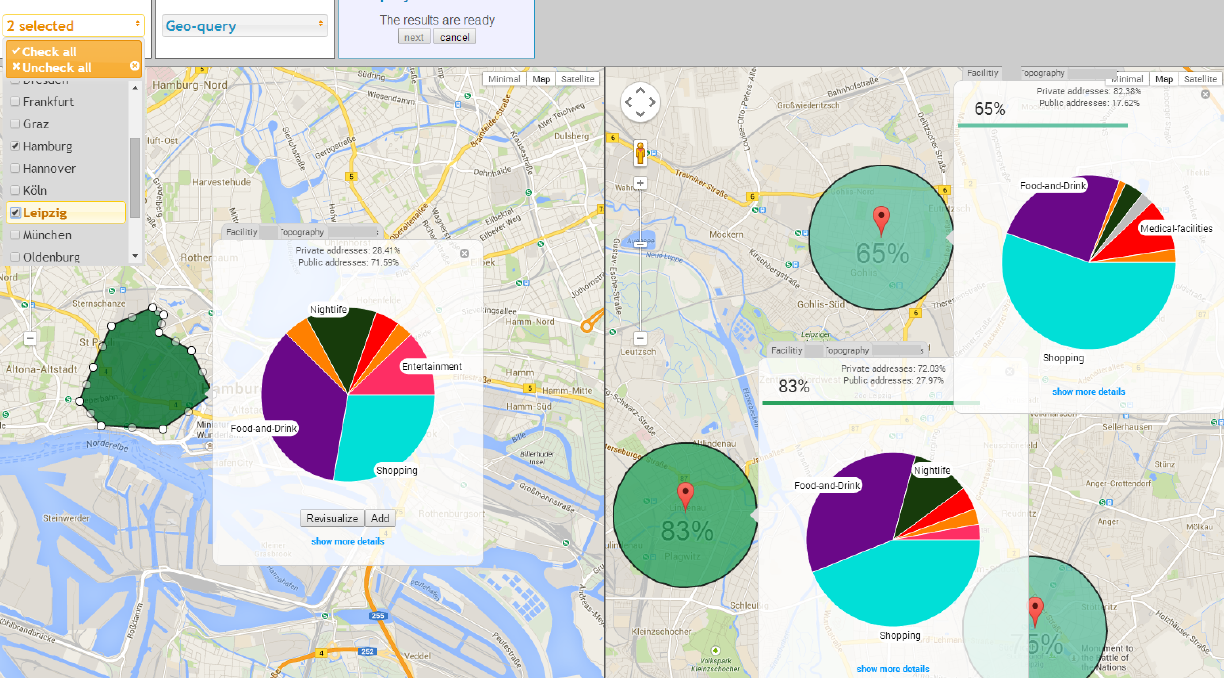
Figure 8 . Ranking of relevant